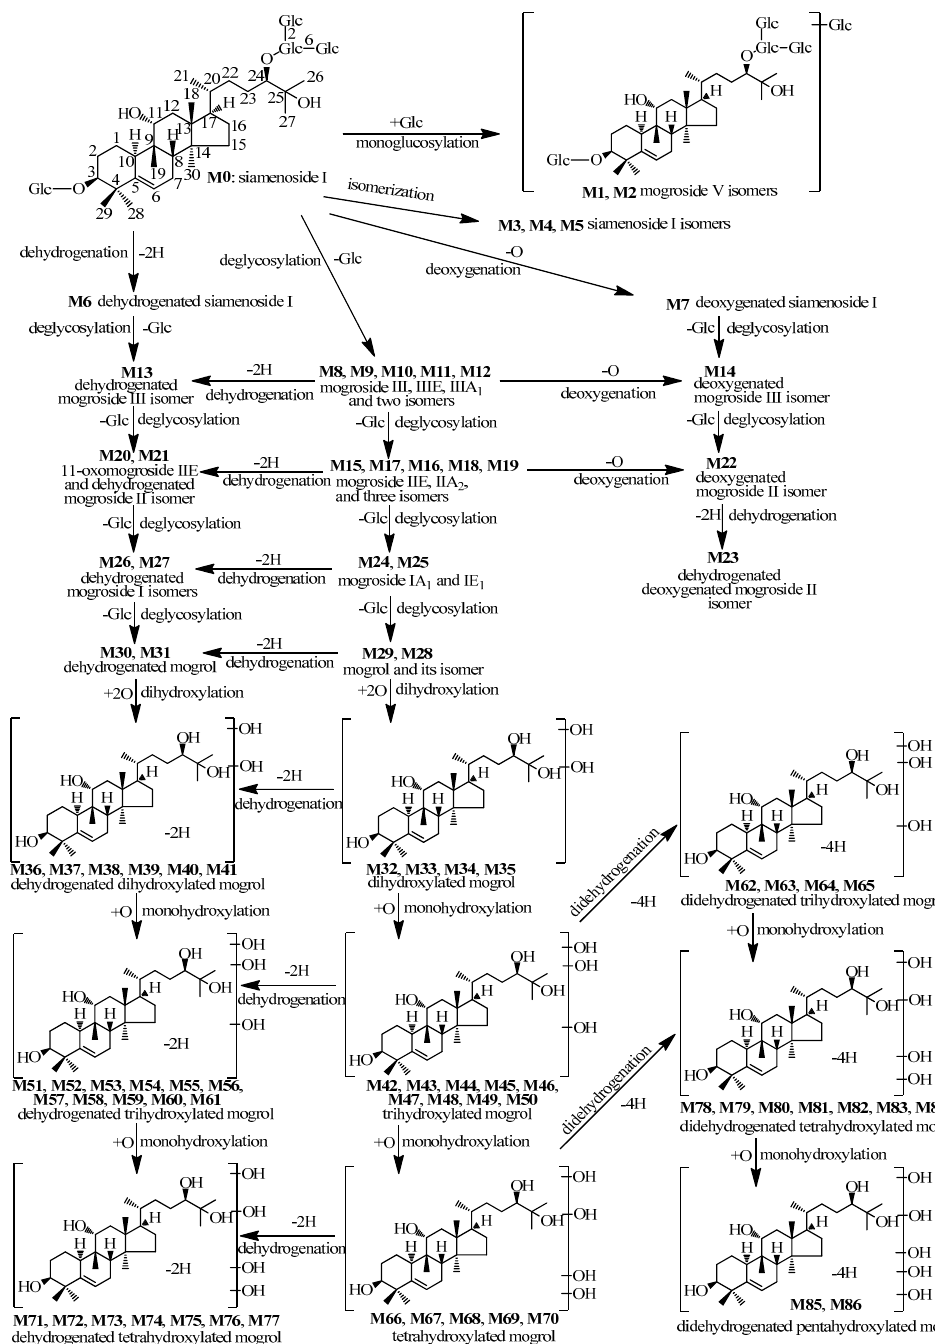
Figure 1. The proposed metabolic pathways of siamenoside I in rats.